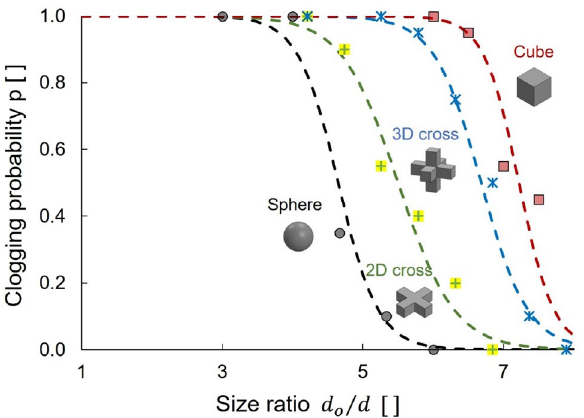
Figure 3. Dry granular flow: Clogging probability as a function of orifice-to-particle size ratio d o / d for the spheres, 2D crosses, 3D crosses and cubes (experimental results). The clogging probability is the ratio of the number of tests that clogged (within a maximum discharge of 4000 particles for spheres, 2D and 3D crosses, and 2000 particles for cubes) to the total number of tests (20 trials). Datapoints: 360 independent experimental realizations. Lines: logistic function (Eq.